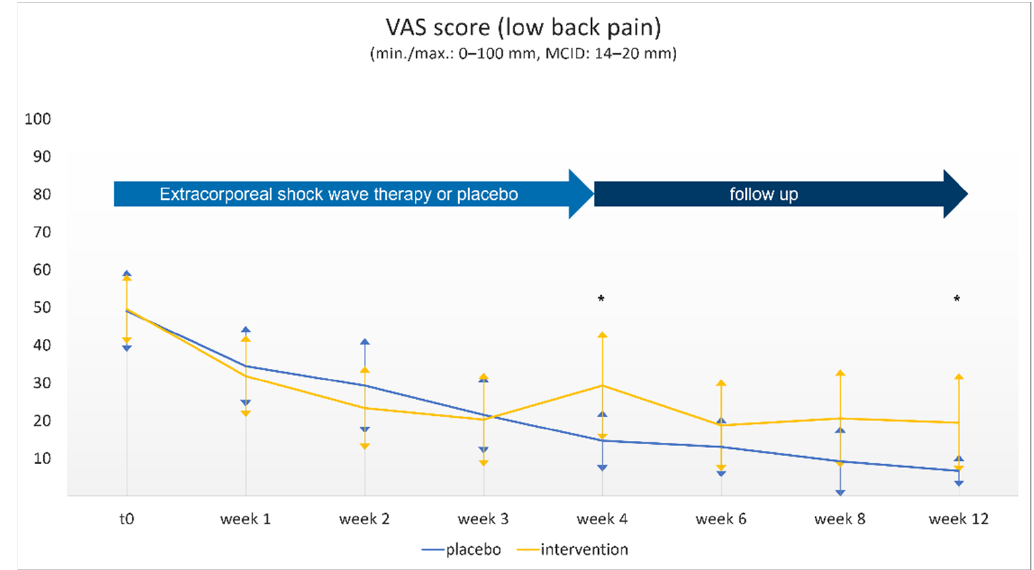
Figure 2. The pain level according to the visual analogue scale for low back pain (VAS-LBP; mean (SD)) for the two groups (intervention vs. placebo) at the eight different time points. Asterisks (*) indicate a significant difference ( p < 0.05).